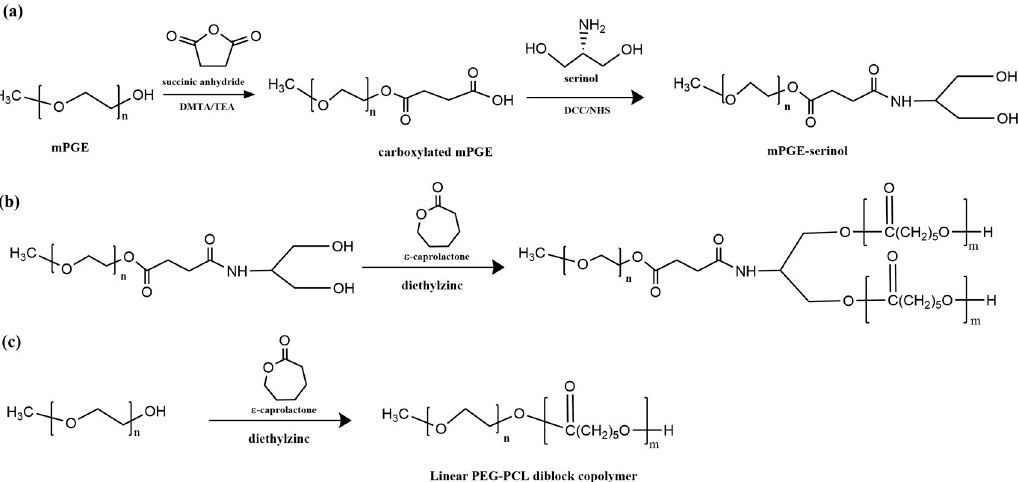
Figure 6. The AB 2 -type miktoarm copolymer (PEG-PCL 2 ) synthesized using a “core-first” strategy (a,b); Linear PEG-b-PCL diblock copolymers synthesize (c) (Adapted from [181]).